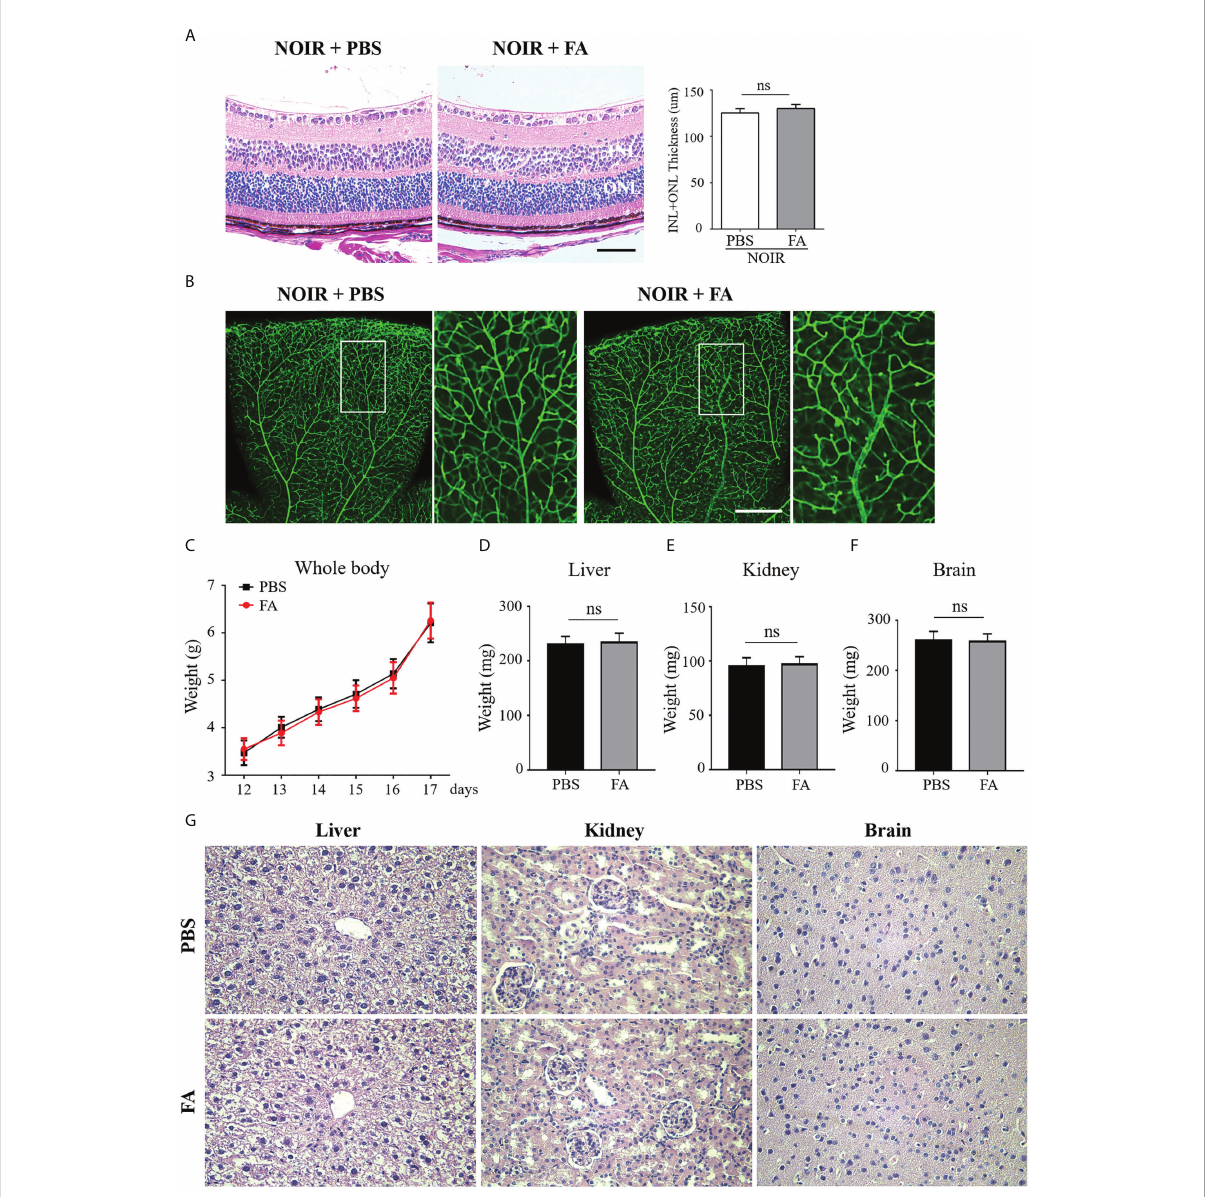
FIGURE 7 FA treatment had no visible retinal or systemic side-effects. FA (50 mg/kg) or vehicle (phosphate buffered saline, PBS) was administered intragastrically twice daily from P12 to P17. (A) H&E staining showing retinal structure and thickness in the FA- and PBS-treated mice. Both groups had well-organized retinal structure. No signi fi cant difference in total thickness of INL (inner nuclear layer) and ONL (outer nuclear layer) between the two groups was observed. n=6 mice. Scale bars: 50 m m. (B) Assessment of retinal vessels using Isolectin B4 staining on retinal fl atmounts. No signi fi cant changes in vascular morphology with FA treatment were observed. Scale bar: 500 m m. (C) The body weight of OIR mice was measured daily from P12 to P17. No signi fi cant difference between FA- and PBS-treated groups was found. n=10 mice. (D – F) On P17, the weight of vital organs including liver, kidney, and brain, had no signi fi cant differences between the two groups. n=10 mice. (G) H&E staining of liver, kidney, and brain tissues in the treatment and control groups. No obvious damage of these organs was noticed in the FA-treated mice. n=6 mice. ns, no signi fi